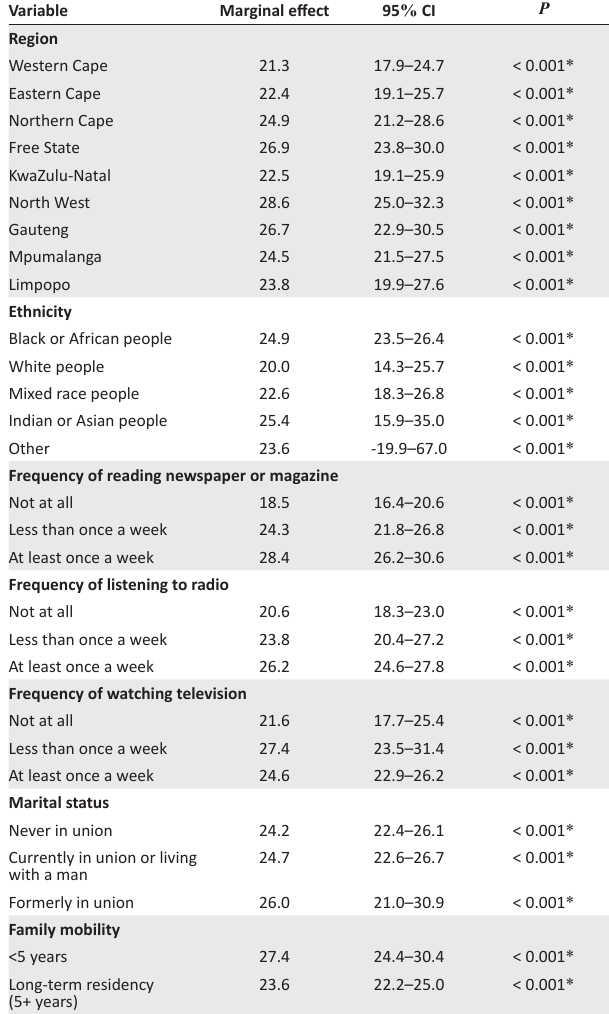
TABLE 1-A1 (Continues...): Marginal interaction effect of HIV self-testing knowledge amongst South African women.